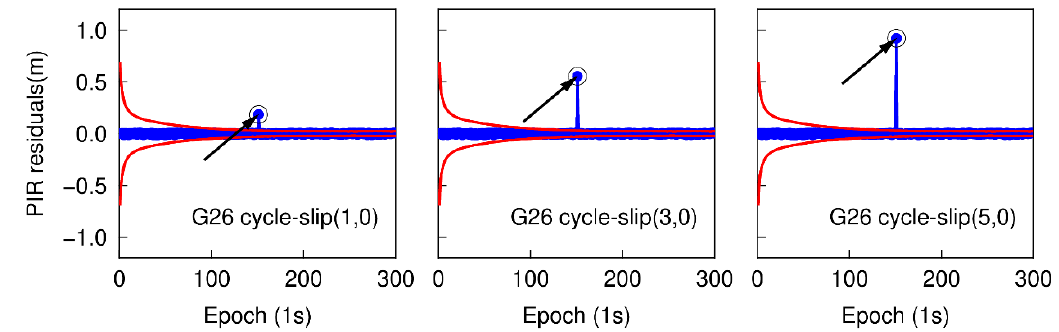
Figure 4. Small cycle-slip detection results using MW combination for E01.